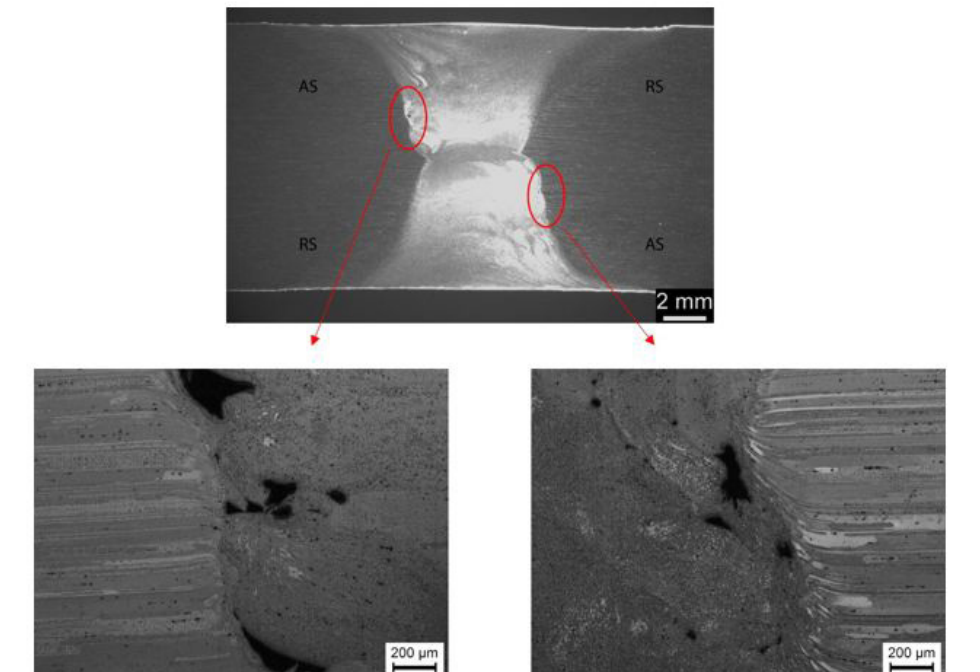
Figure 6. Volumetric defects of AA2050-T84 joints processed with the lowest energy input (welding condition